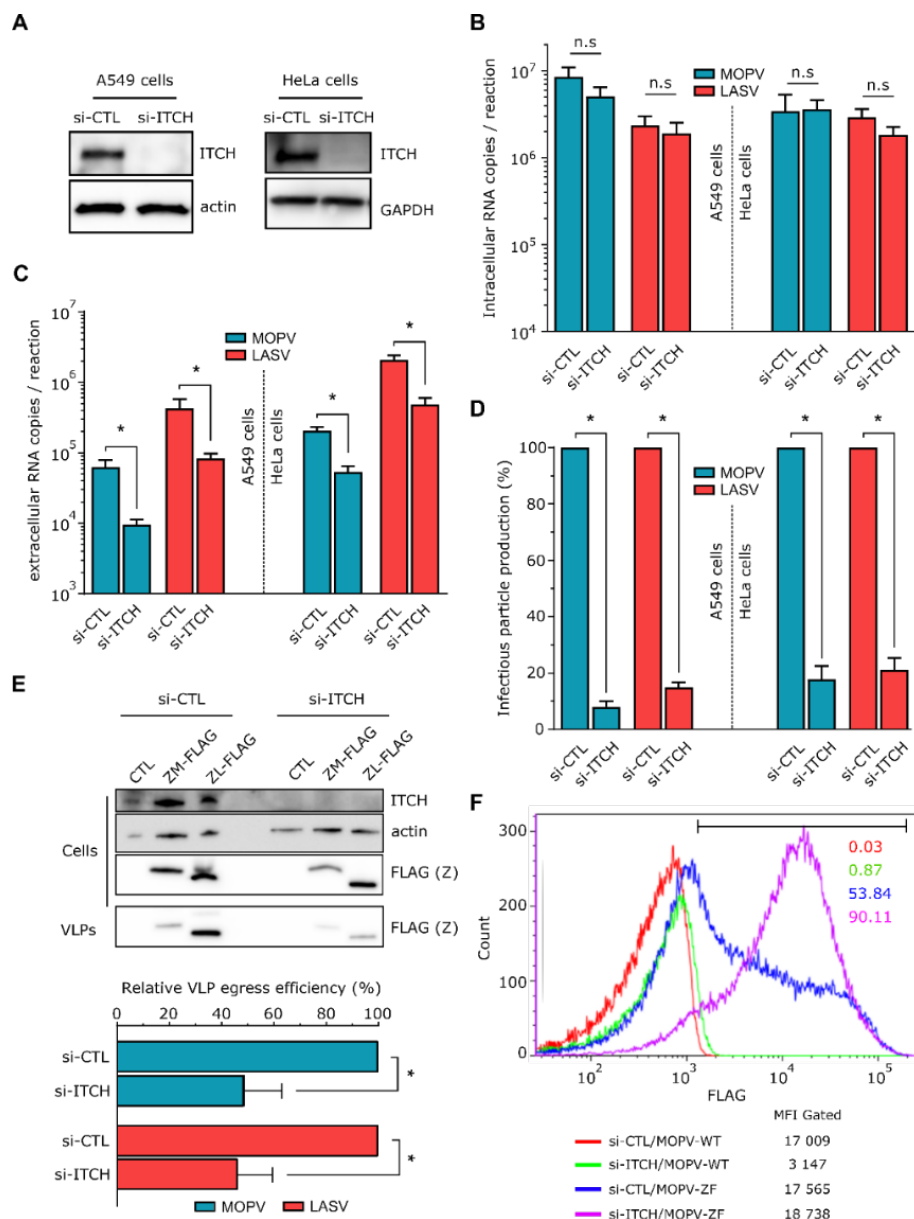
Figure 4. Effect of ITCH on MOPV and LASV infection. ( A ) A549 and HeLa cells were transfected with the indicated siRNA and cultured for 72 h before analysis of silencing efficiency by western blotting ( n = 4 independent experiments). ( B – D ) The same cells as in ( A ) were then infected with LASV or MOPV with a MOI of 0.01 (A549 cells) or with a MOI of 0.1 (HeLa cells) for 1 h before being cultured for two days (A549 cells) or three days (HeLa cells) at 37 ◦ C. Viral RNA was then extracted from the cells ( B ) and supernatants ( C ) for quantification by RTqPCR. Infectious particles from the supernatants were also titrated on Vero cells ( D ). Error bars represent the standard error of the means from four independent experiments. * p < 0.05, as determined by the Mann–Whitney test. ( E ) The 293T cells were transfected with the indicated siRNA and cultured for 72 h before being transfected with an empty plasmid (CTL), or with the FLAG-tagged Z protein of MOPV or LASV (ZM-FLAG or ZL-FLAG). After 15 h of culture, cell extracts were directly analyzed by western blotting (cells) and supernatants were harvested, deposited on a sucrose cushion, and ultracentrifuged at 56K rpm for 90 min, before analysis of the pellet by western blotting (VLPs). Representative results are shown, along with a graph representing the intensity of the VLP Z bands. Error bars represent the standard error of the